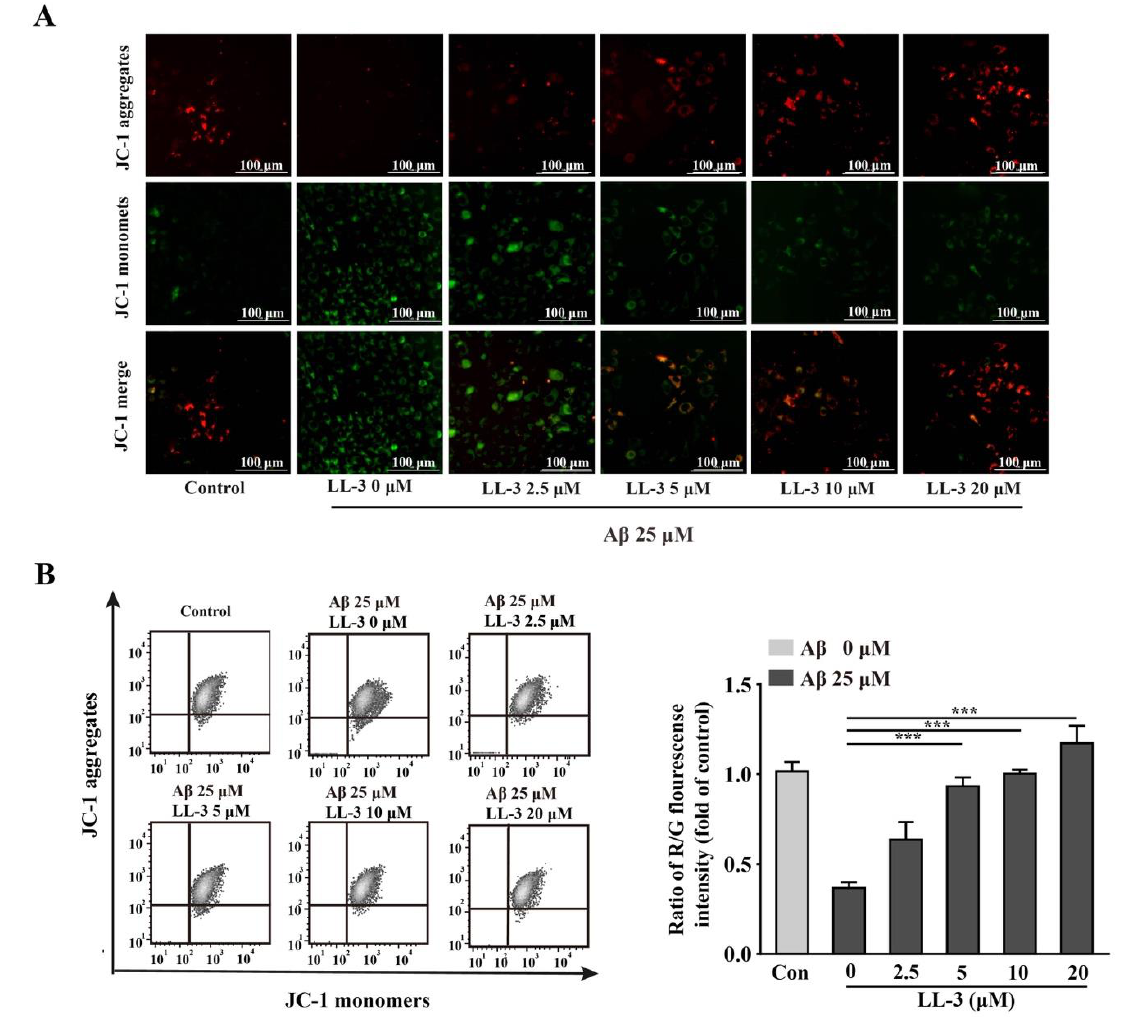
Figure 4. LL-3 recovered mitochondrial membrane potential (MMP) from Aβ 25-35 damage. MMP, evaluated by JC-1 probe was assessed after LL-3 co- incubation with Aβ 25-35 for 24 h. LL-3 was pretreated before Aβ 25-35 for 30 min. ( A ) The MMP alteration was assessed by Cytation 5 Imaging Reader using JC-1 staining. ( B ) The ratio of R/G fluorescence intensity was detected using flow cytometric assay. All experiments were detected three times and shown with mean ± SD and *** p <0.001 compared to Aβ 25-35